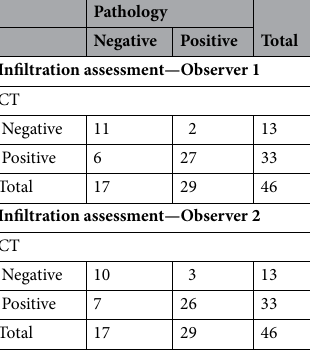
Table 2. Comparison of CT findings of extrapancreatic perineural invasion with pathological results in 46 patients and the ROC-curves for both